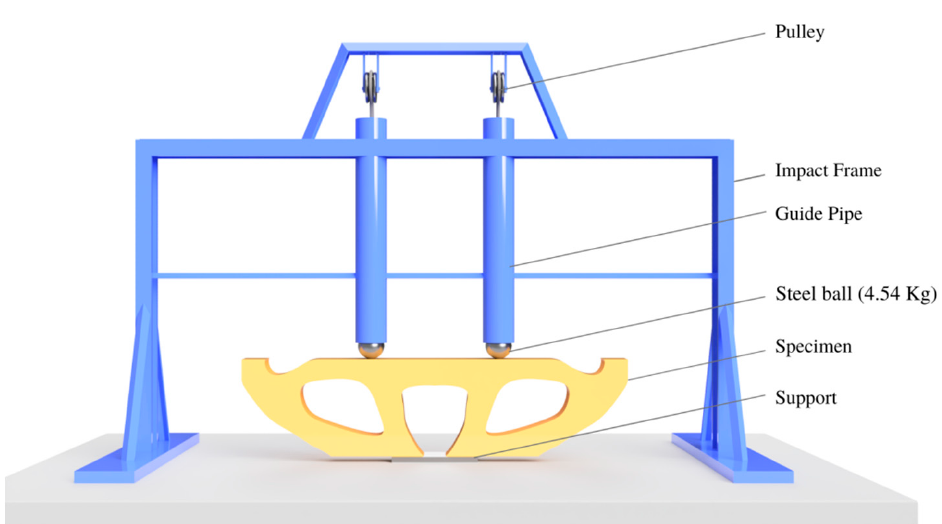
Figure 10. Impact test setup.